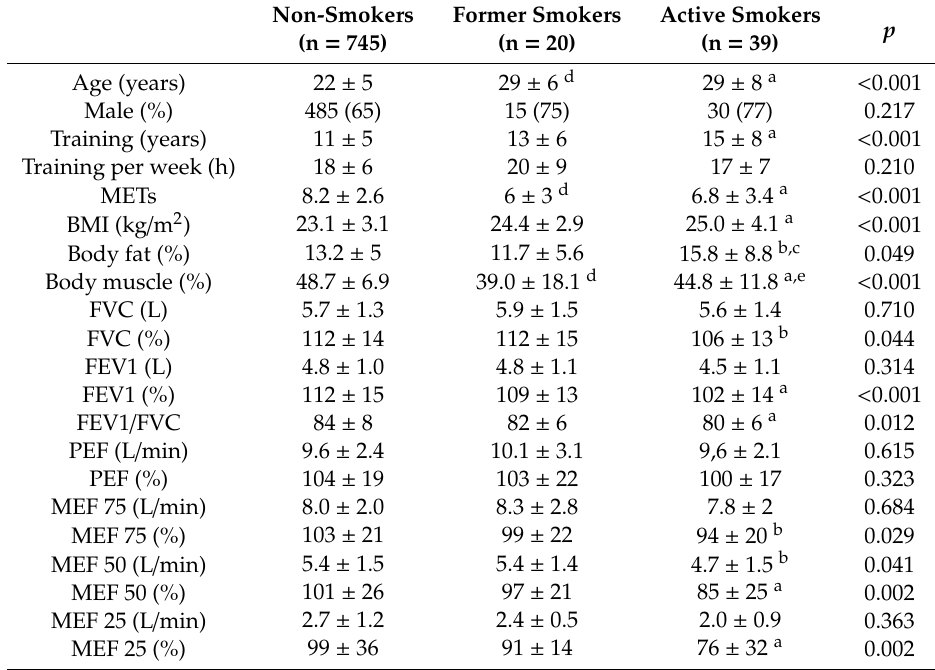
Table 1. Demographic characteristics and clinical parameters in the whole study population*.